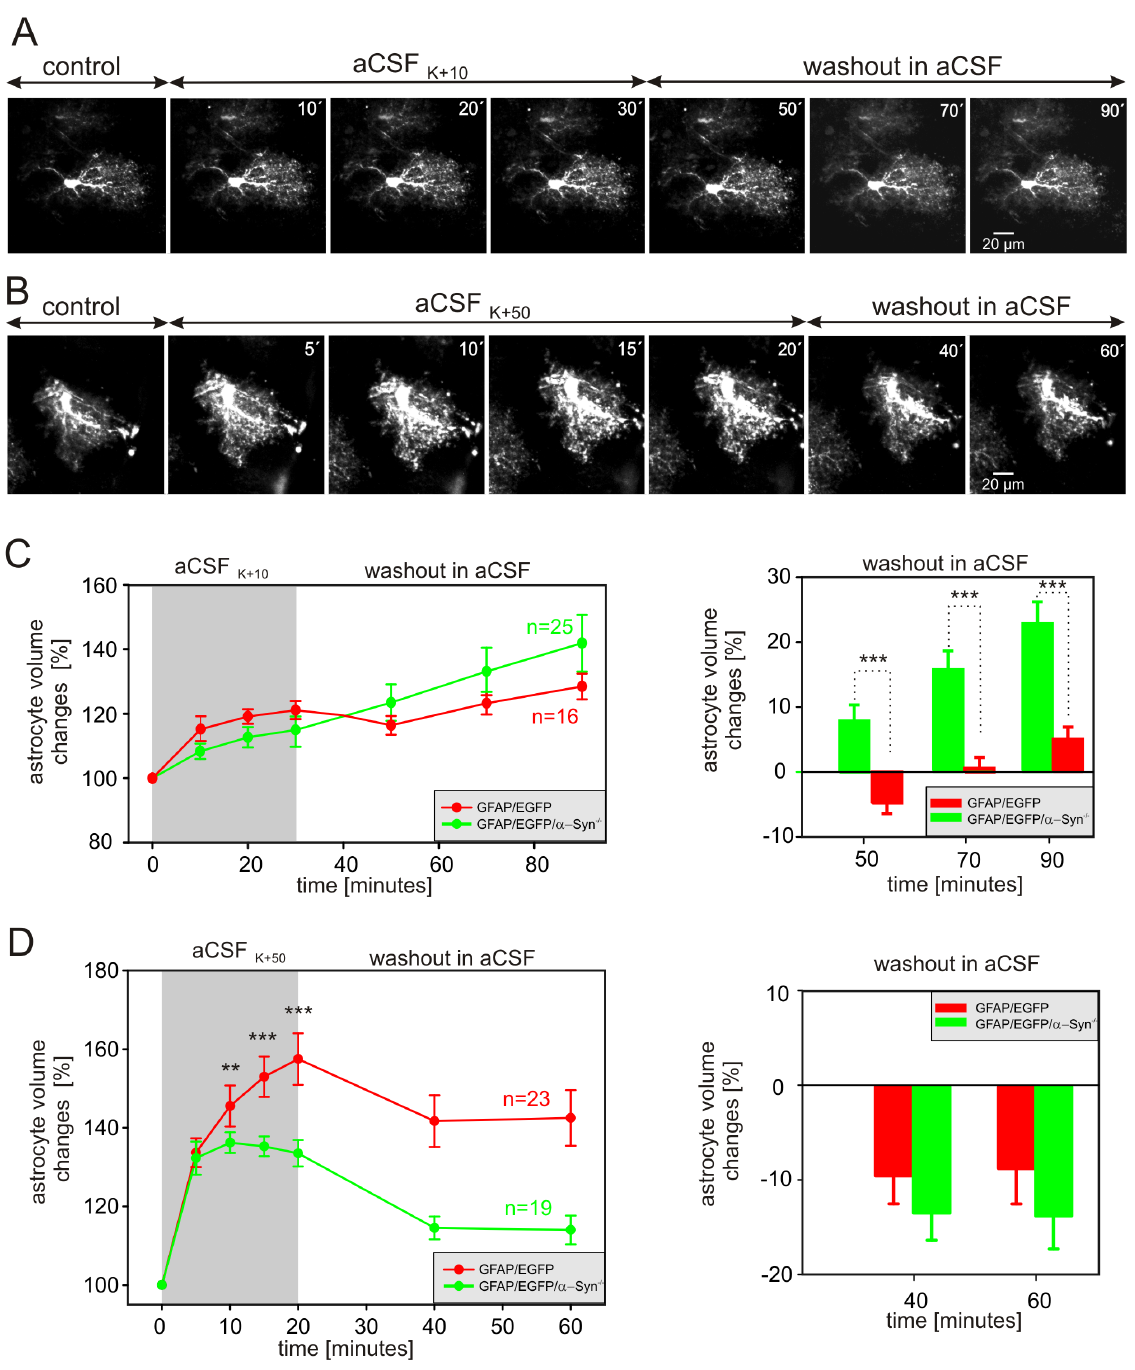
Figure 6. Astrocytic volume changes evoked by increased extracellular K + concentration in the cortex of GFAP/EGFP and GFAP/EGFP/ a -Syn 2 / 2 mice. ( A, B ) Superimposed confocal images of EGFP-labeled astrocytes in the cortex of GFAP/EGFP/ a -Syn 2 / 2 mice recorded in aCSF (control), during exposure to aCSF containing 10 mM K + (aCSF K + 10 , A ) or 50 mM K + (aCSF K + 50 , B ), and during washout. The astrocytic volume was quantified every 10 minutes during exposure to hyperkalemia and every 20 minutes during washout. Time-dependent changes in the total astrocytic volume in GFAP/EGFP (red) and GFAP/EGFP/ a -Syn 2 / 2 mice (green) during a 30-minute exposure to aCSF K + 10 ( C left ) or a 20-minute exposure to aCSF K + 50 ( D left ) and during